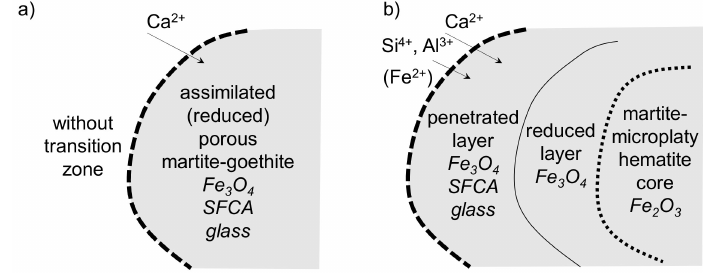
Figure 18. Ore assimilation scheme in SM-A